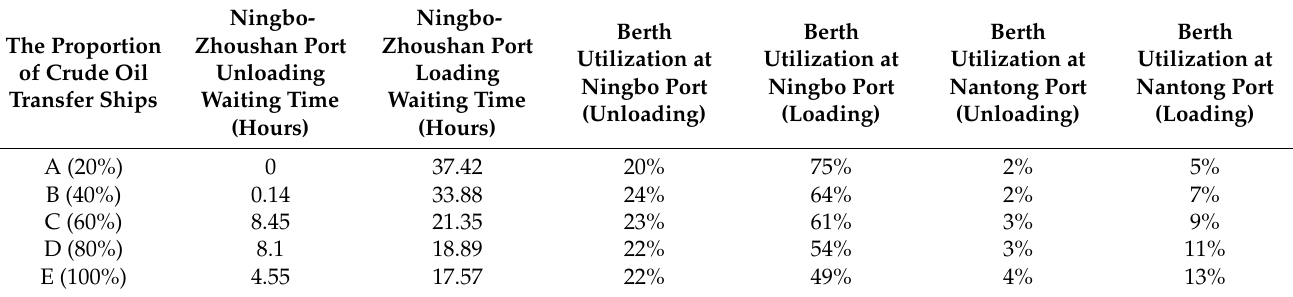
Table 1. Tankers waiting time and berth utilization rate of transfer